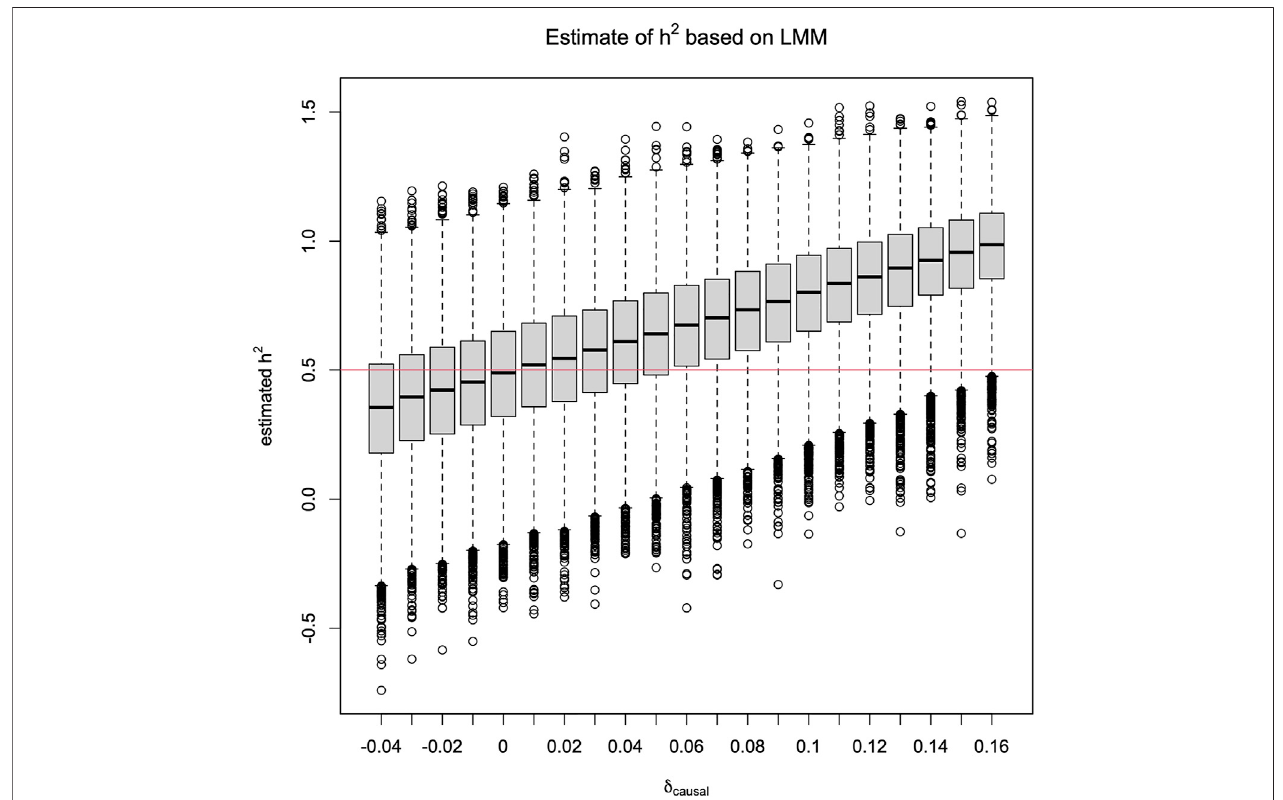
FIGURE 1 | Box plots of ^ h 2 , estimated from the linear mixed-effect model ( Eq. 4 ) against δ causal . The true heritability of the phenotype is h 2 = 0.5. The minor allele frequencies p causal = p tested =0.2and10,000independentreplicatesofphenotypesandgenotypesfor65siblingpairsweresimulatedforeach δ causal value.Theempirical type 1 error rates are shown in Figure 3 as black